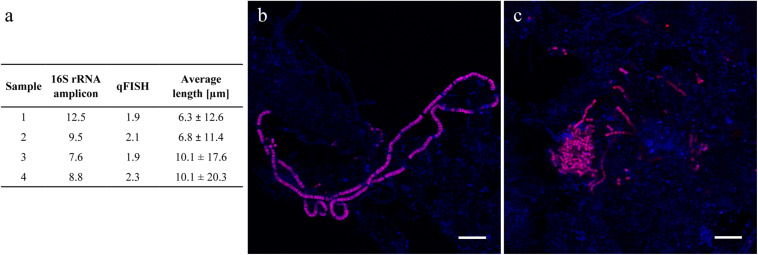
(a) Abundance of Trichococcus in four Danish activated sludge plants and their corresponding average cell length measurement; (b,c) Variable morphology of Trichococcus in Danish WWTPs. Scale bar represents 10 μm.